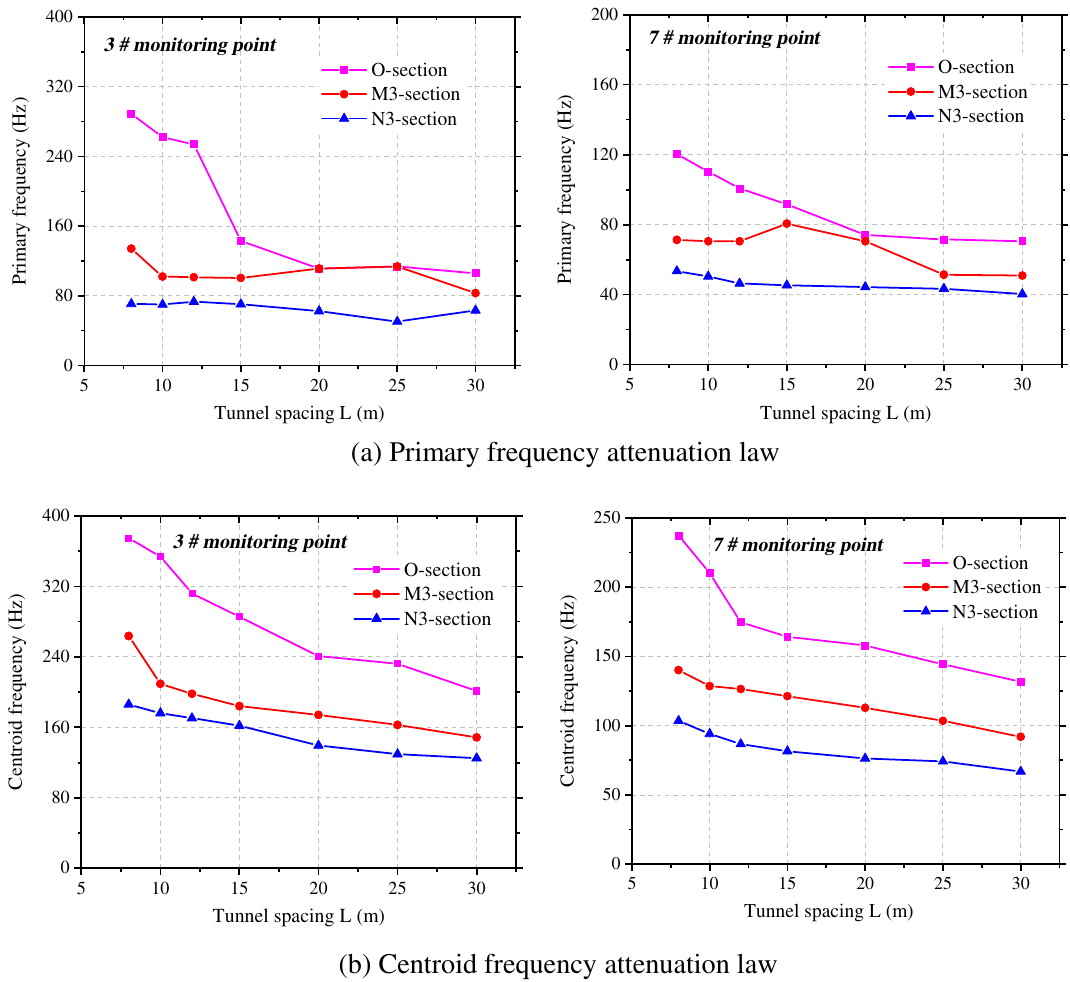
Figure 11. Frequency attenuation law of measuring point 3# and 7# under tunnel spacings. Location Section O Section M Section N